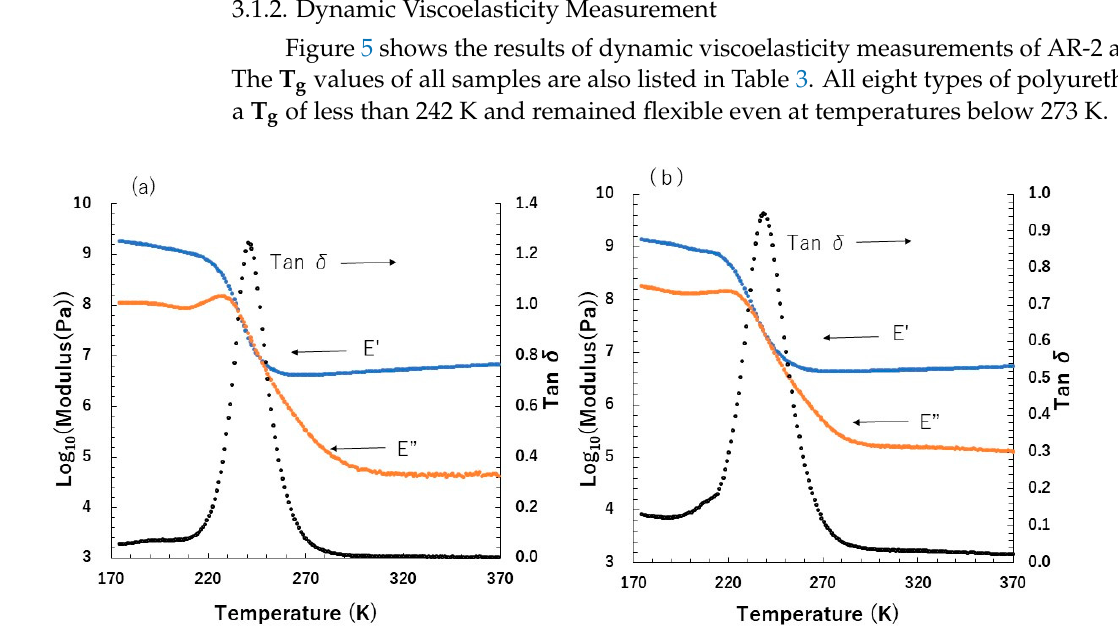
Figure 5. Dynamic viscoelasticity measurement results of polyurethanes: ( a ) AR-2 and ( b ) AL-1 samples.